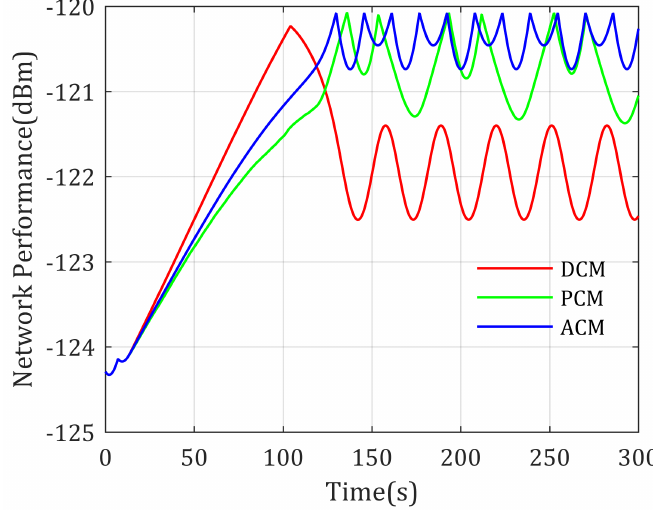
Figure 7. Network performance for two static agents end-to-end communication with known channel parameters.